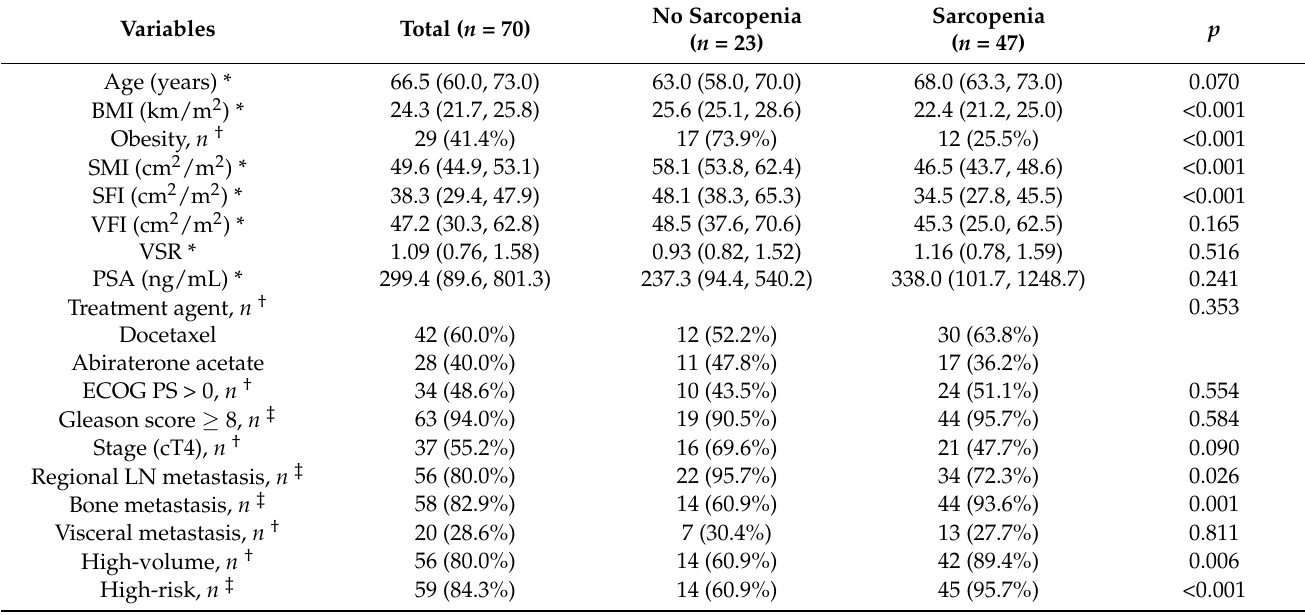
Table 1. Baseline